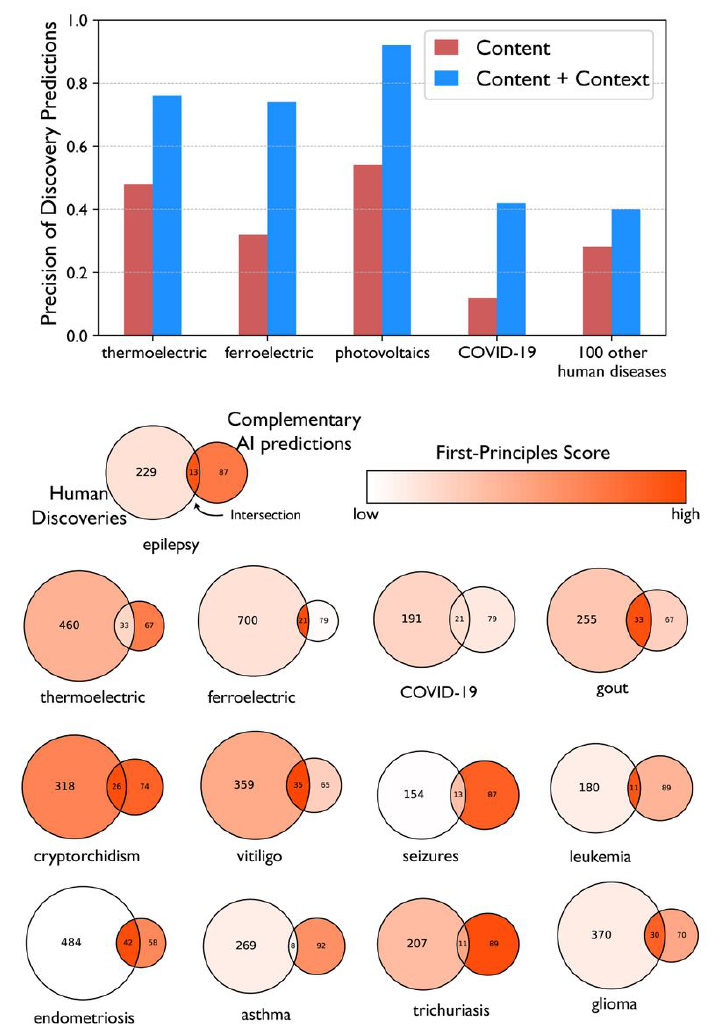
Figure 3. Improving discovery with content and context . Top: Precision scores associated with the prediction of future material discoveries using artificial intelligence (AI) models based on content alone, with the left three replicated from (Tshitoyan et al. (2019), compared with those based on content plus context and data plus metadata, which manifest a 100% increase (Sourati & Evans, 2021). Bottom: Discoveries made by scientists versus discoveries made by an AI model built with content and context to complement human discoveries. Numbers shown inside the regions indicate their size and the intensity of each region represents average first-principles scores precomputed for the associated materials. These scores indicate the potential of any given material to possess a targeted property. We used the following scores: power factor (PF) for thermoelectricity (Ricci et al., 2017; Tshitoyan et al., 2019), simultaneous polarization for ferroelectricity (Smidt et al., 2020), and cosine similarity of drugs and diseases in protein–protein interaction network for human diseases (Gysi et al.,